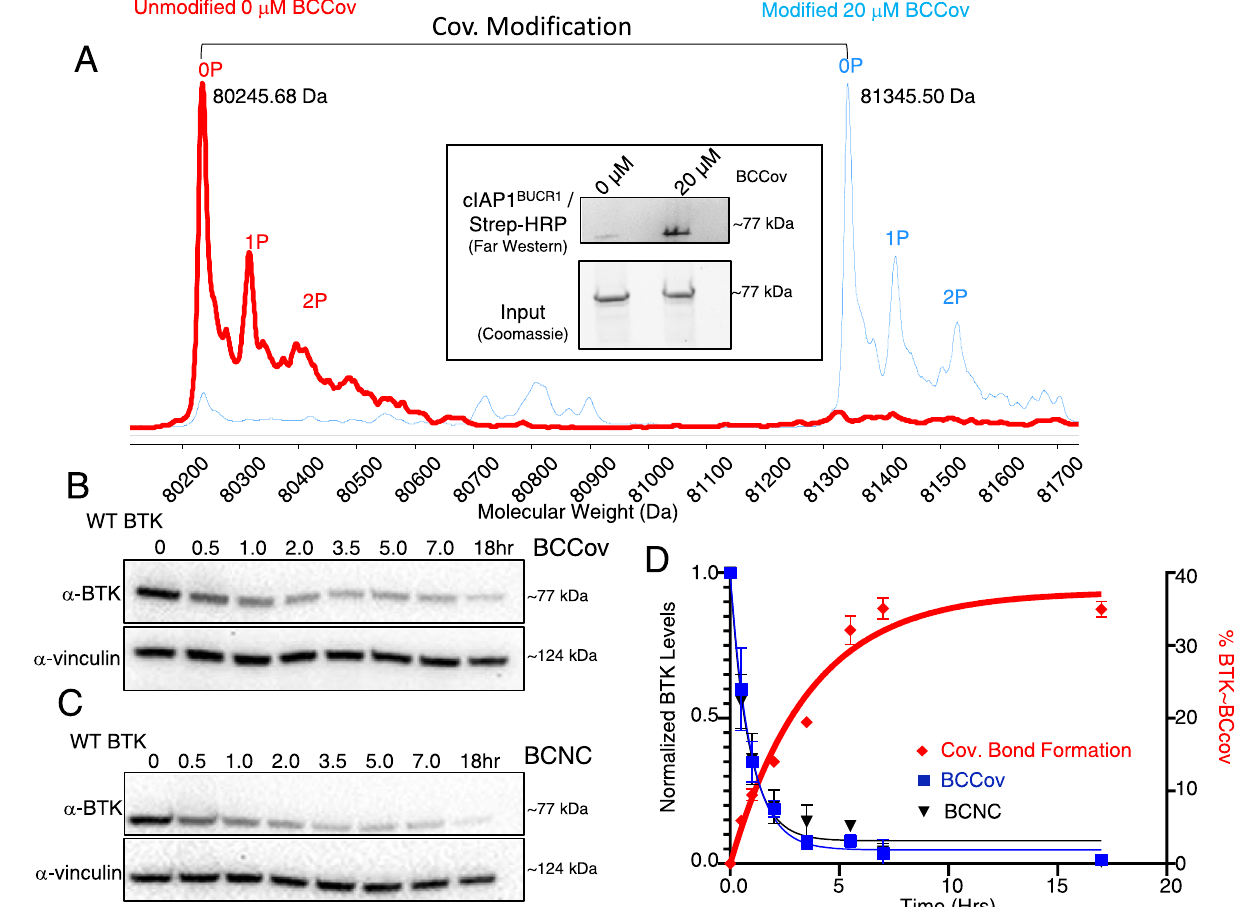
Fig. 2 | BCCov covalently labels BTK in cells. A Deconvoluted intact mass spec- trumchromatographofimmunopuri fi edBTK FL afterDMSOtreatment(red)orafter cellular treatment with 20 µ M BCCov (blue). Caliper indicates mass shift repre- senting BCCov modi fi cation. Heterogeneous phosphorylation states 0P, 1P, or 2P represent 79.9Da mass shifts. The inlay shows a Coomassie-stained gel showing Immunopuri fi ed BTK FL and corresponding far western blot with biotinylated- cIAP1 BUCR1 detected with streptavidin HRP. Each is a representative image for 3 independent experiments. B , C Representative western blot for time-dependent